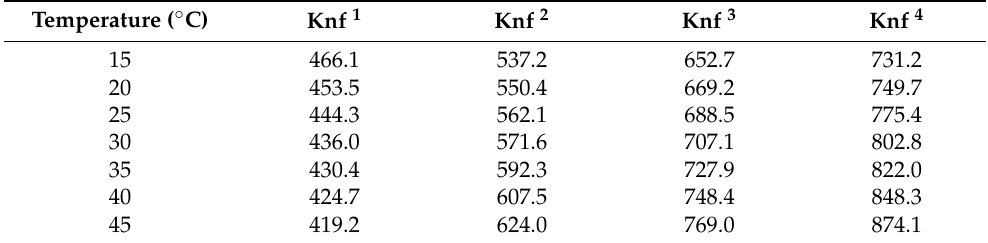
Table 3. Variation of thermal conductivity (Knf) with temperature ( ◦ C) and amount of